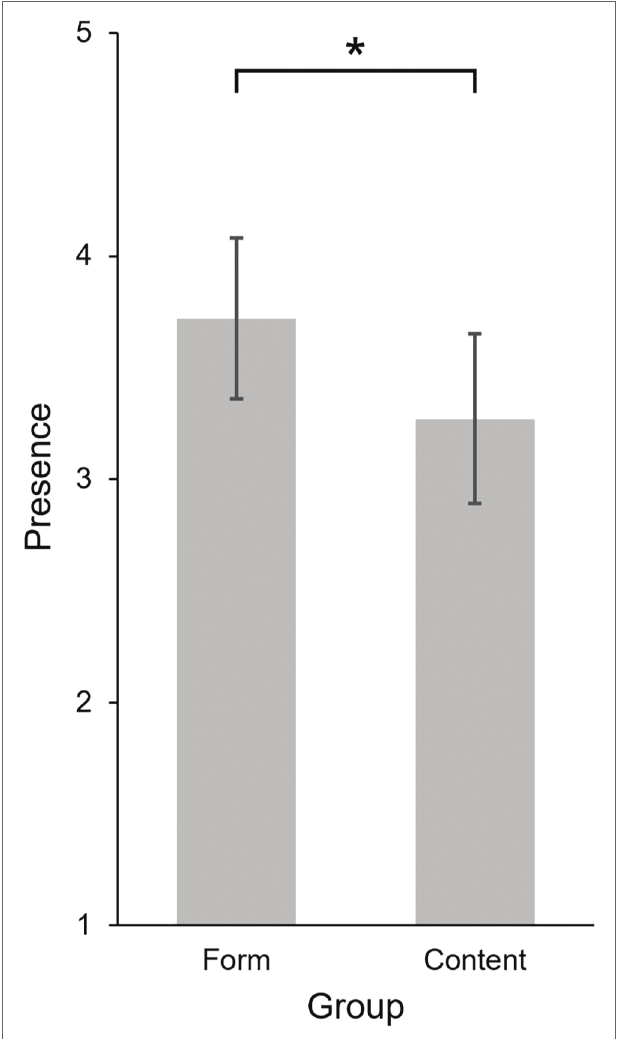
FIGURE 2 | Spatial presence self-report scores in the form condition and content condition. Higher values indicate stronger presence experiences. Error bars indicate 95% CIs of the SEM. * p <